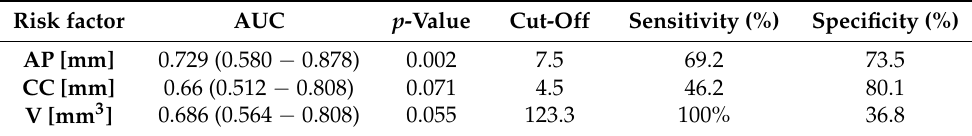
Figure 5. Volume in the ROC analysis of the chance for incorrect diagnosis of pituitary lesions in a conventional MRI examination in children with growth or puberty disorders. The receiver operating characteristic (ROC) analysis shows that pituitary volume (V) is also a statistically significant (area under curve [AUC] lower CI 95% > 50%) predictor of the appropriateness of contrast administration in the diagnosis of pituitary focal lesions in our research group. ROC analysis of the gland volume testifies the lower specificity rate (37%) than sensitivity (100%) and the volume cut-off = 123 mm 3 indicates the proper contrast diagnostics in (AUC ∼ ) 69% of patients. Table 3. Summary of the results of the receiver operating characteristic (ROC)